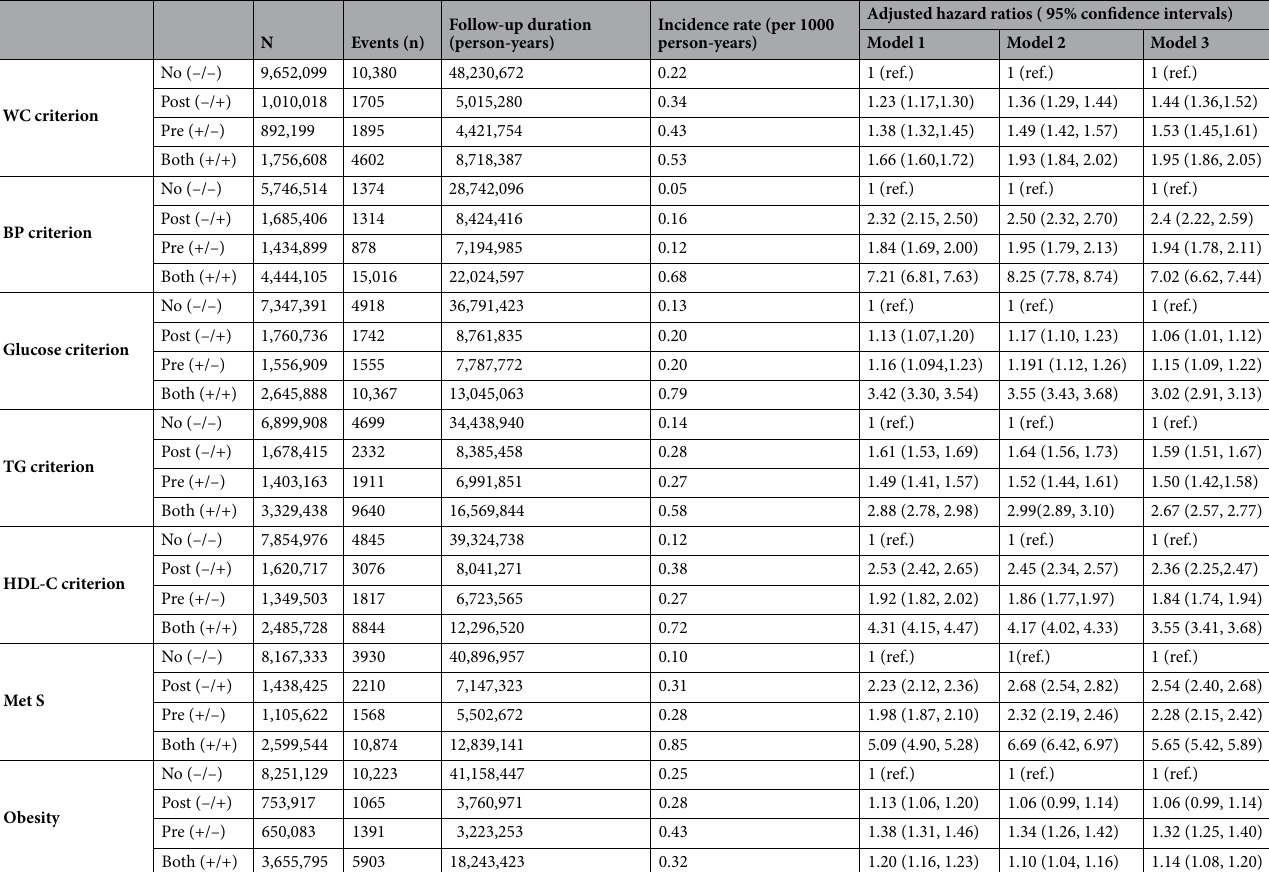
Table 3. Adjusted hazard ratios, 95% confidence intervals, and incidence rates of end-stage renal disease development according to the change of each MetS component. Model 1, adjusted for No. of MetS components at 1st visit, age and sex; Model 2, Model 1 plus adjusted for smoking, drinking and exercise; Model 3, Model 2 plus adjusted for estimated GFR. WC waist circumference, BP blood pressure, TG triglyceride, HDL-C high- density lipoprotein cholesterol, MetS metabolic